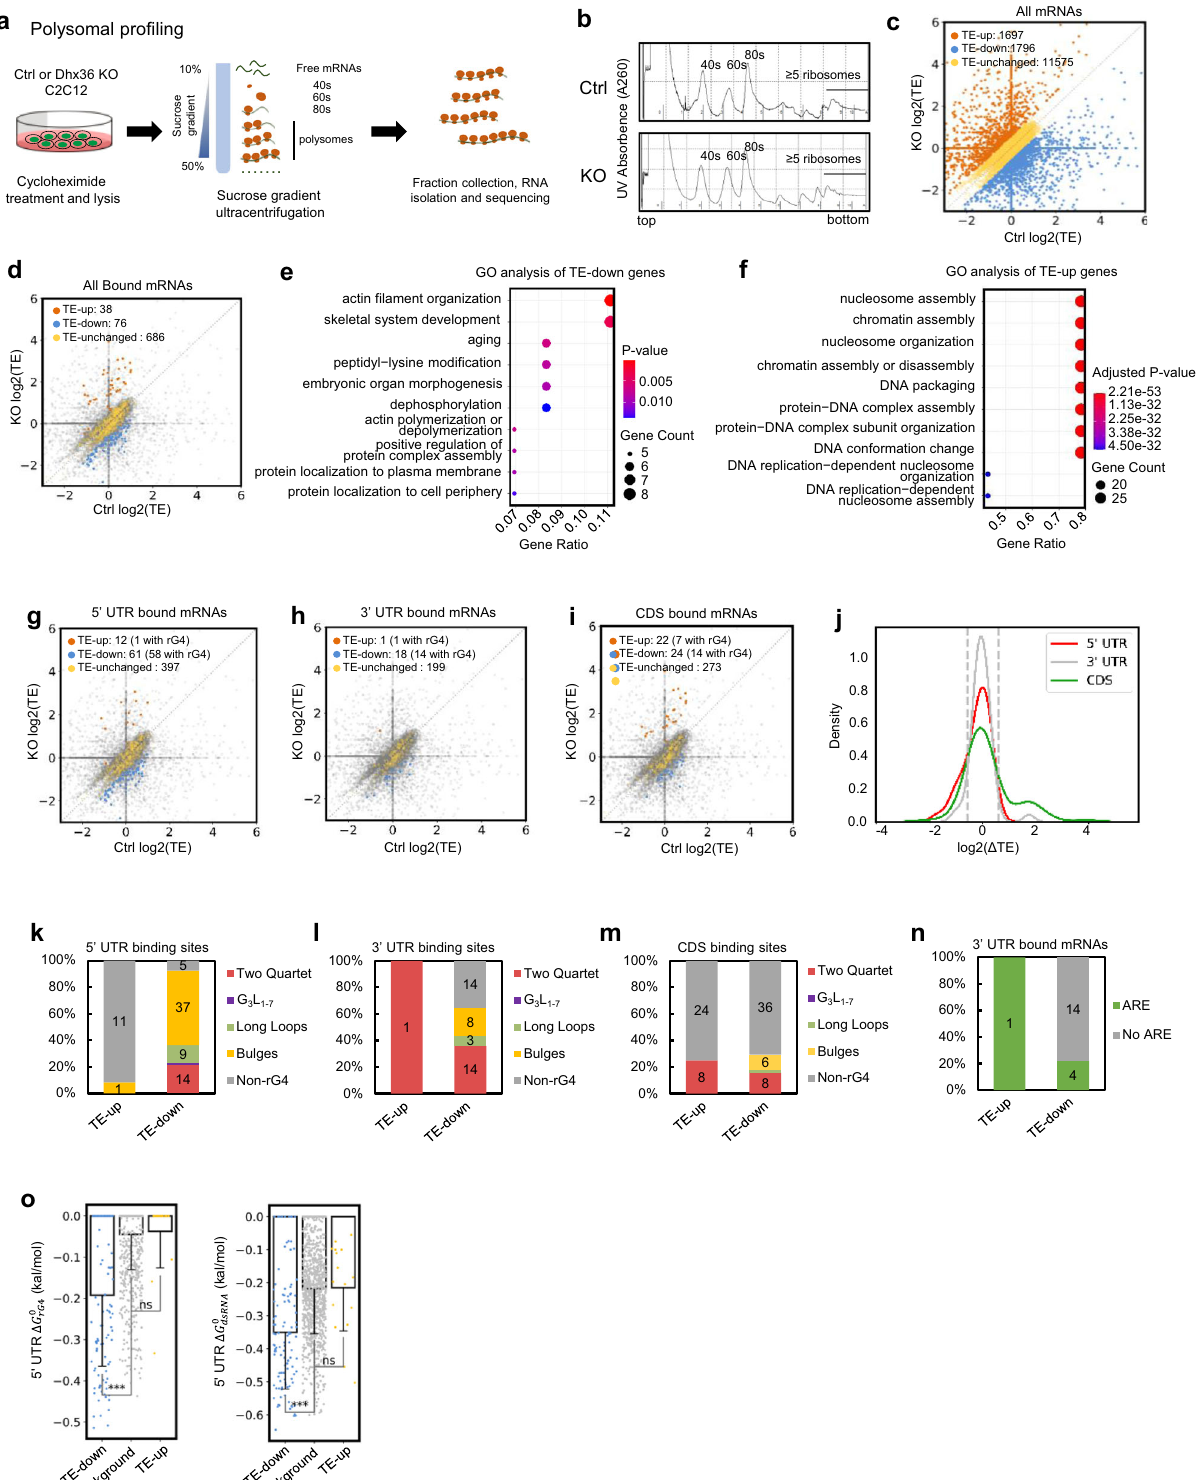
down subset than those in the TE-up subset. Finally, the sequence context favored the formation of rG4 structures over dsRNAs as 4 G 0 displayed a much larger fold difference compared to rG 4 background (mean energy value 4.3 fold, P = 2.64 × 10 – 23 ) than 4 (Fig. 5o). Taken together, these fi ndings revealed that rG4 structures